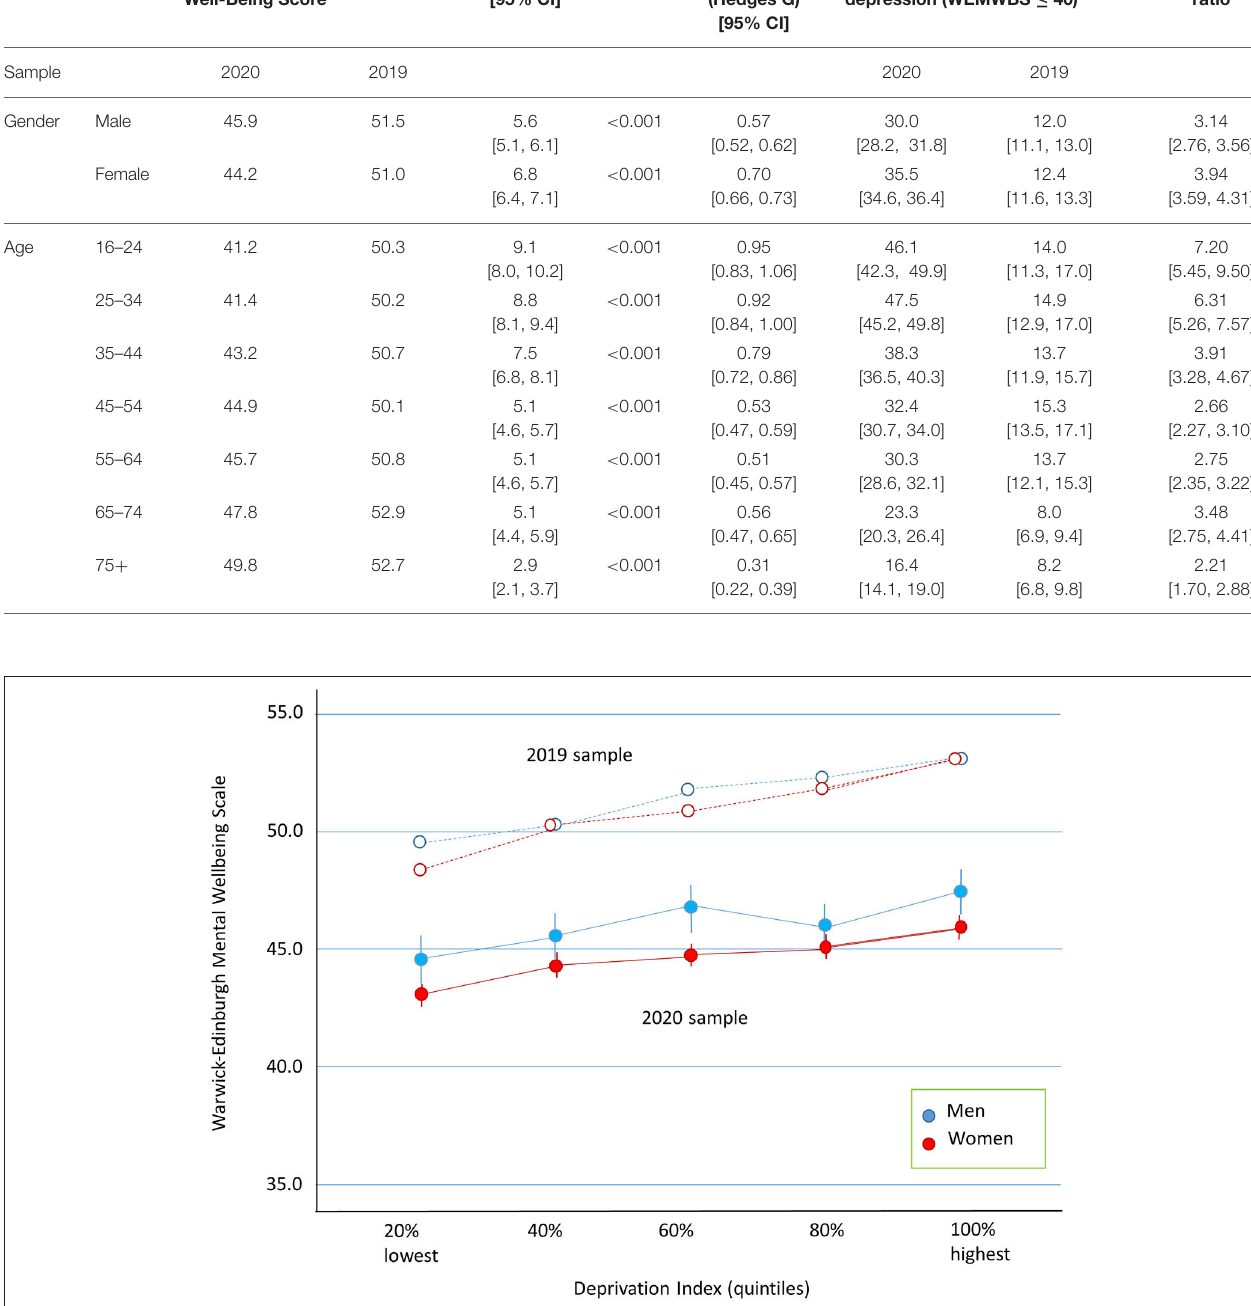
p Effect size Difference Low mental health/probable [95% CI] (Hedges G) depression (WEMWBS ≤ 40) [95% CI]